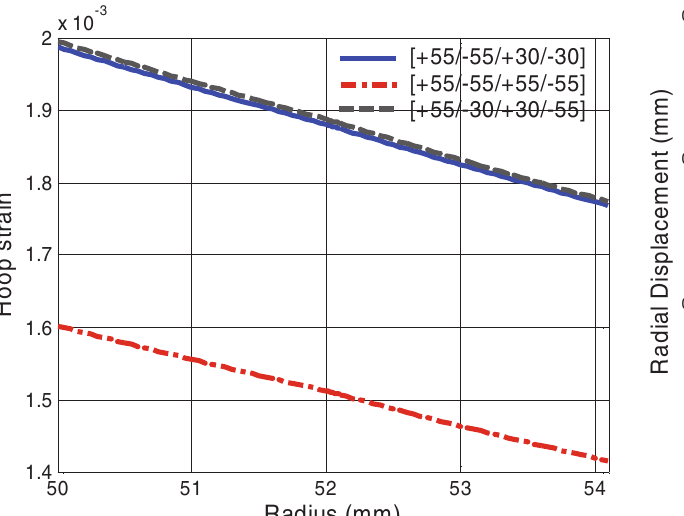
Fig. 7. The distribution of radial displacement through the